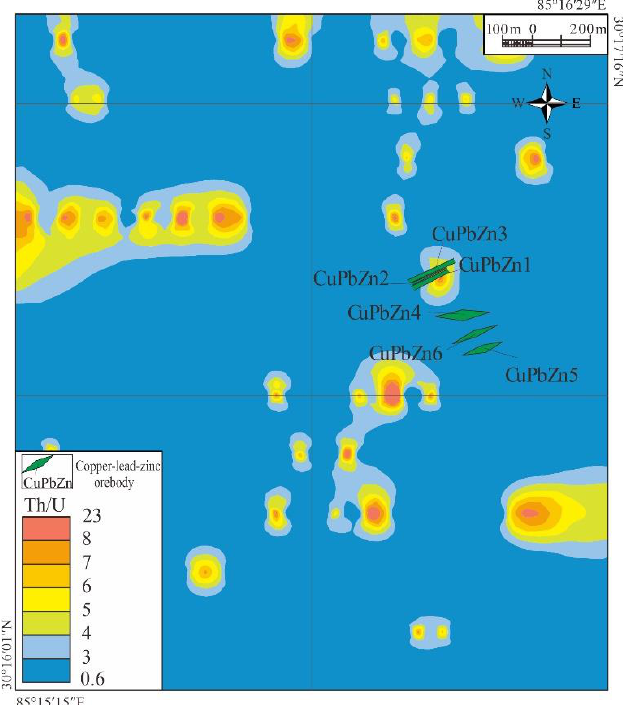
Figure 9. Th/U redox environment geochemical map of Central Nuocang.